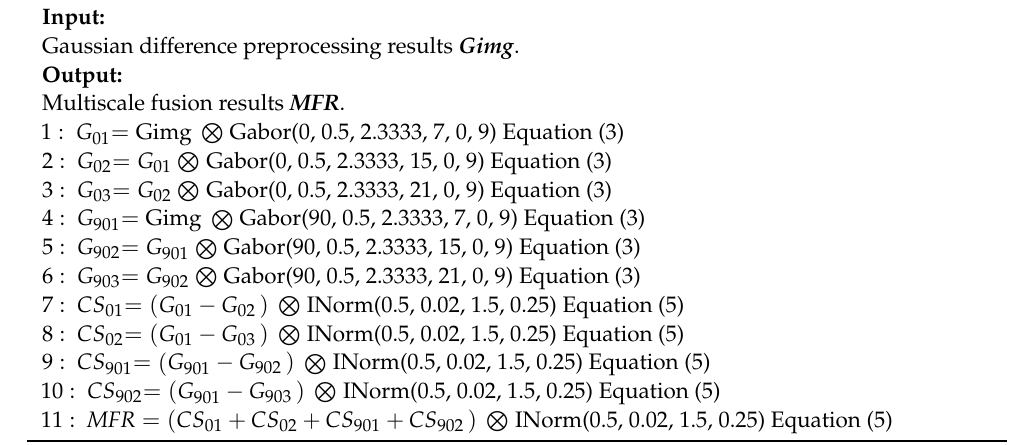
Algorithm 1: Get the result of multi-scale feature